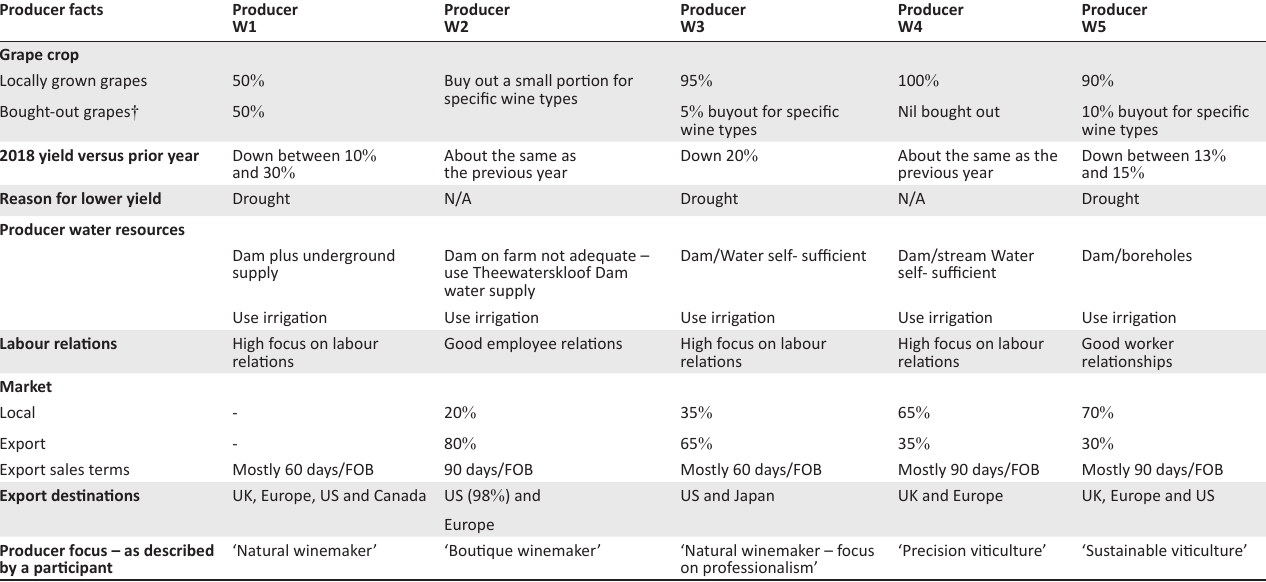
TABLE 4: Key attributes of the participating wine